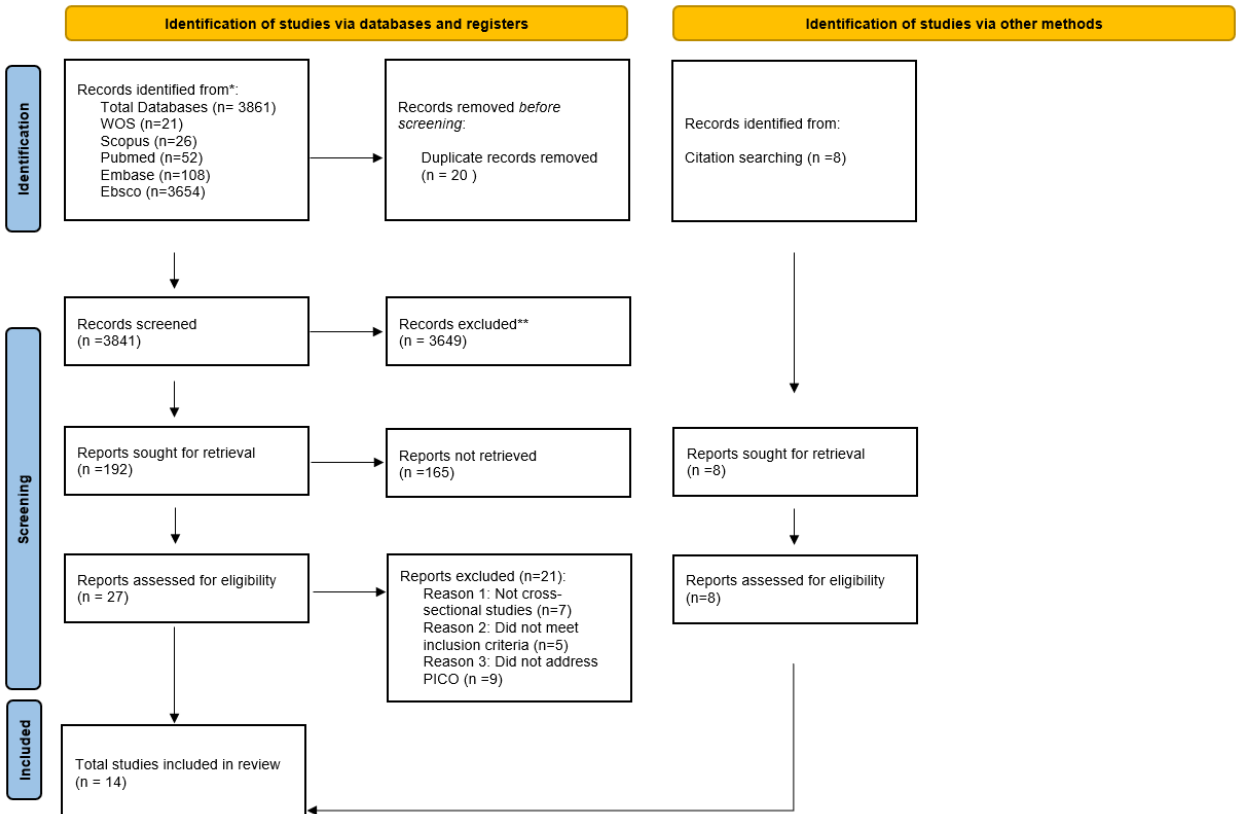
Figure A1. PRISMA flowchart to show the selection of articles.